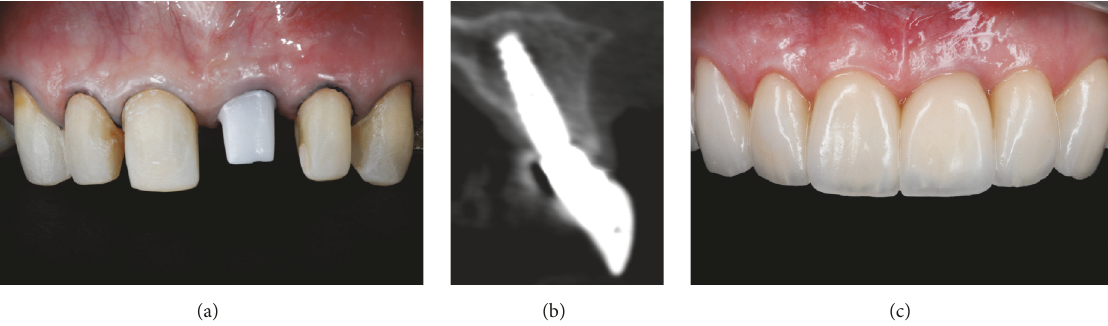
Figure 10: The adjacent teeth were prepared and an impression was made to produce all ceramic restorations (a). A CBCT demonstrated the creation of bone tissue around the implant and the increase of the gingival tissue one year after ITR (b). Results obtained one year after the zenith-driven rehabilitation